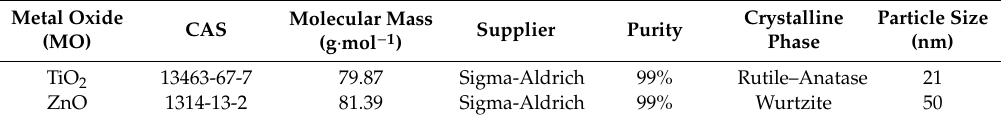
Table 4. Characteristics of the reagents and their respective